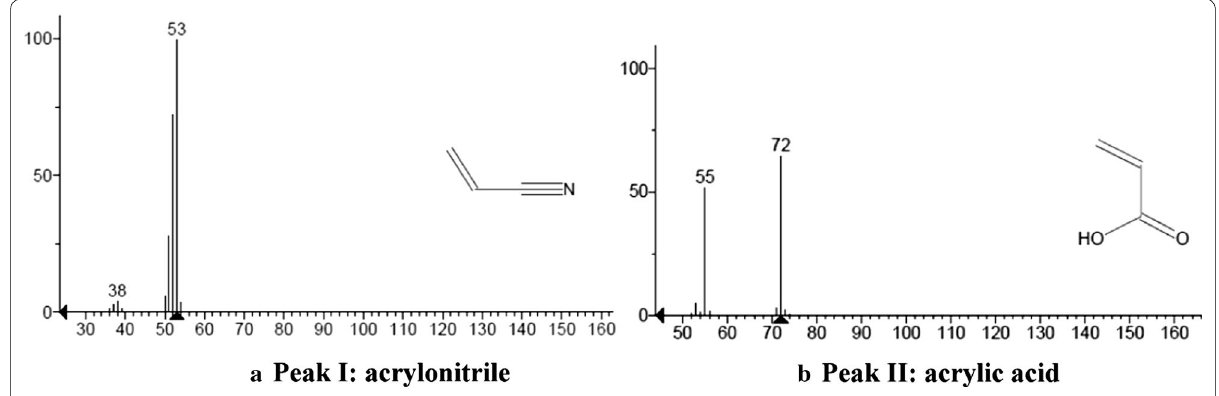
Fig. 4 Mass spectrogram of Peak I and Peak II